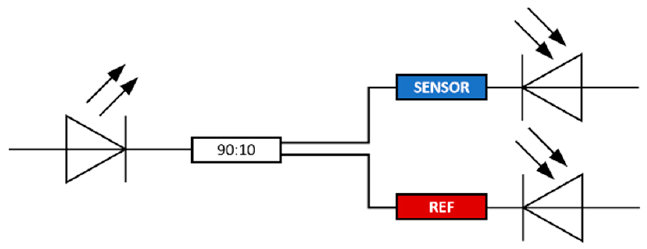
Figure 3. Schematic representation of the optical sensing setup.